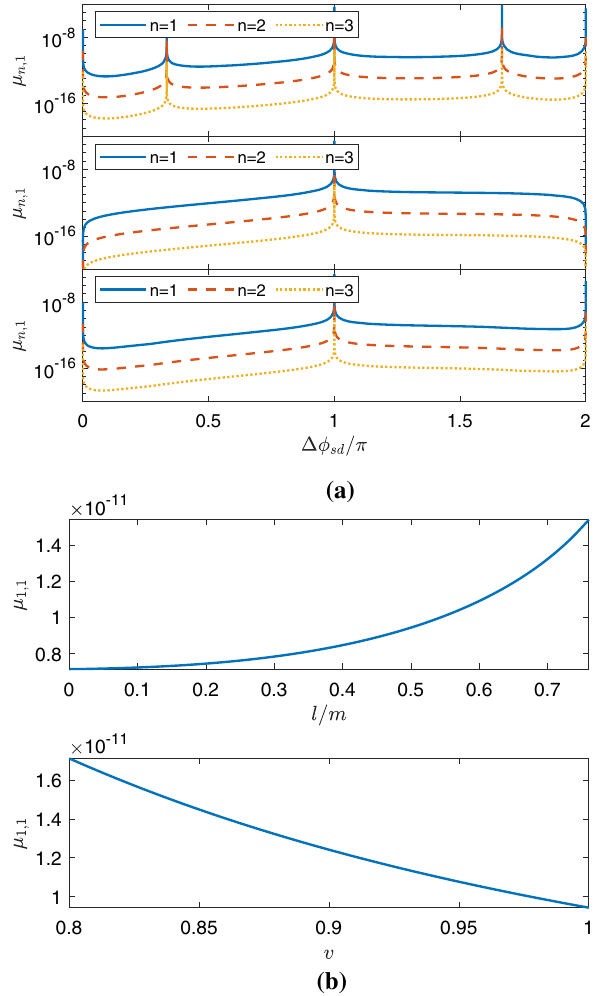
Fig. 5 a The magnification of the relativistic images in the Hayward BH spacetime. m , r d , v, l are the same as in Fig. 4 and r s = r d / 2 (top), r s = r d (center) and r s = 1 . 5 r d (bottom) for n = 1 , 2 and 3. b The dependence of the magnification on l while holding v = 1 (top) and on v while holding l / m = 0 . 5 (bottom). (cid:8)φ sd = 5 π/ 6 and r s = r